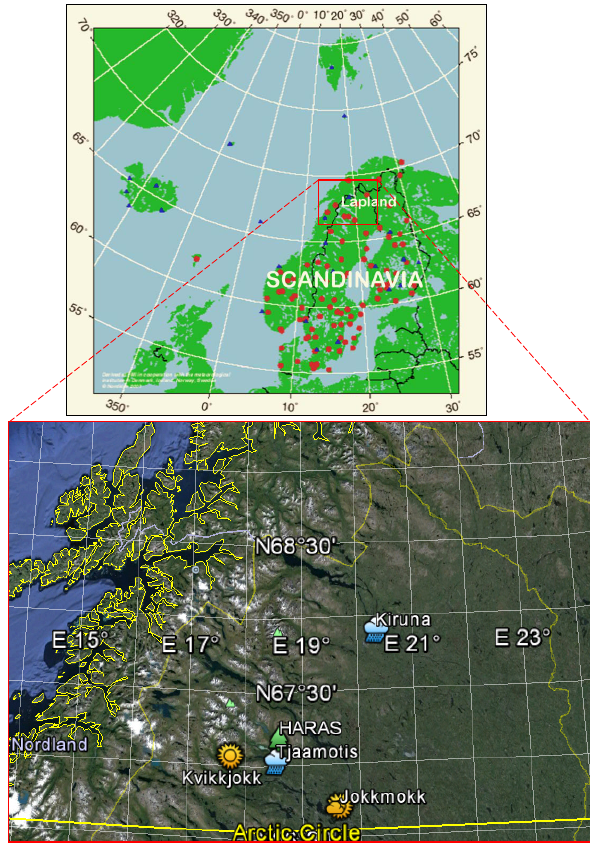
Figure 1. Location of Hårås plot, Kvikkjokk, Tjåmotis and Kiruna meteorological stations in the Swedish part of Lapland. Meteosta- tion map of the NORDKLIM database: stations with data series longer than 90years, shorter than 90years (modified from: Tuomen- virta et al., 2001).